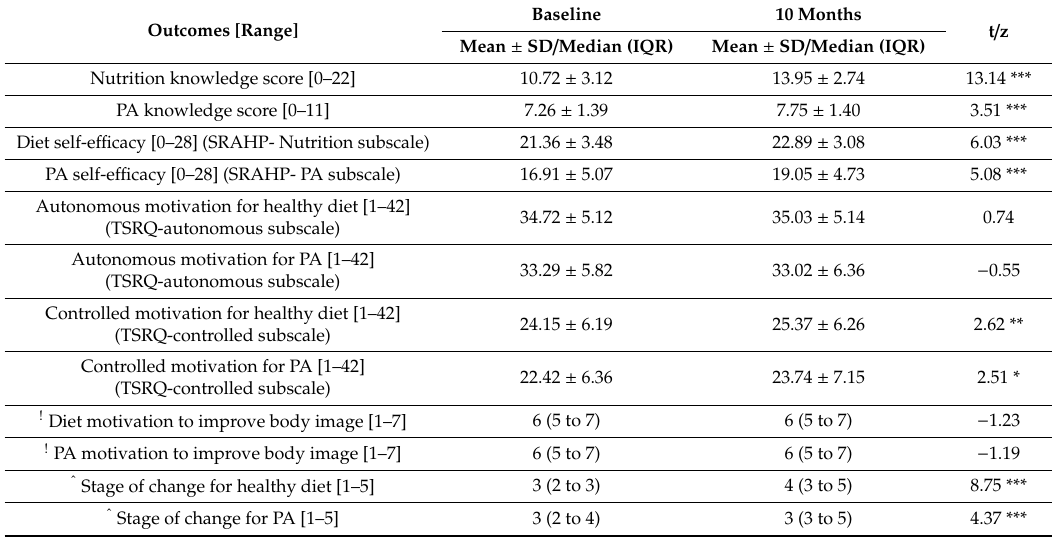
Table 2. Comparison of psychological outcomes at baseline and 10-month